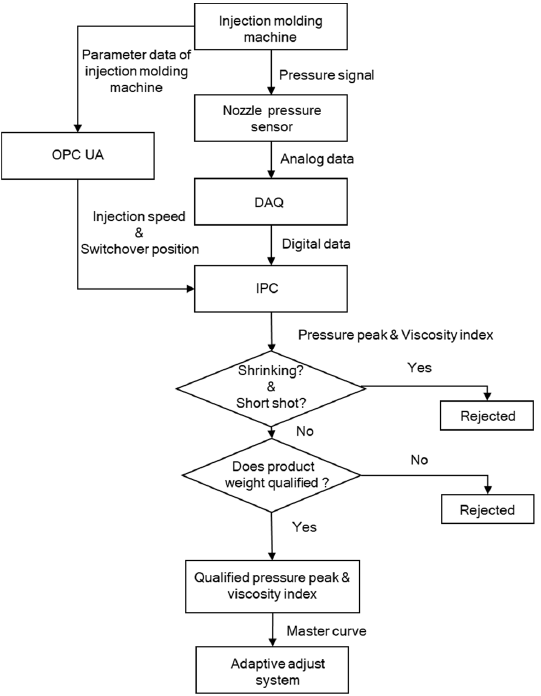
Figure 6. Decision flow chart of the master curve.